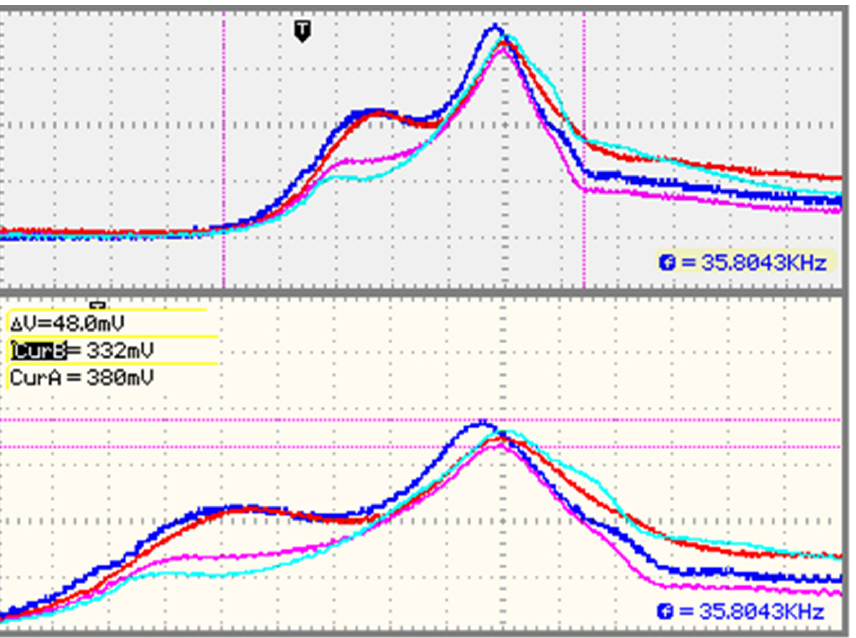
Figure 8. Minimum current mismatch amongst four IGBT transistors from the same production lot.